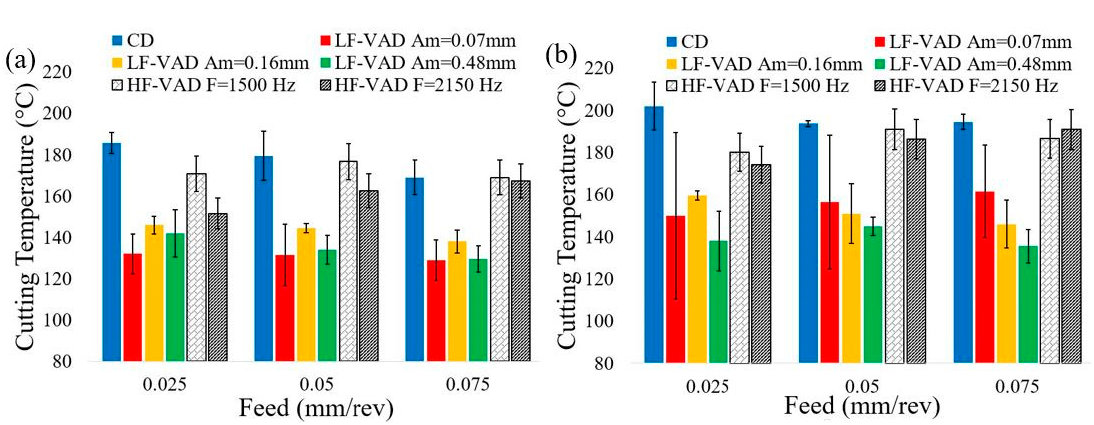
Figure 8. Effect of LF-VAD on the CFRP chips at f = 0.075 mm/rev, N = 3000 rpm, and A m = 0.48 mm. Figure 9. Effect of CD on the CFRP chips at f = 0.075 mm/rev and N = 3000 rpm.